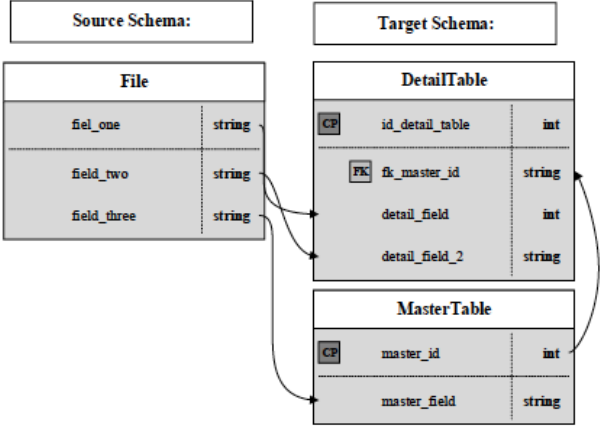
Fig. 1. Schema representation with a non-linear